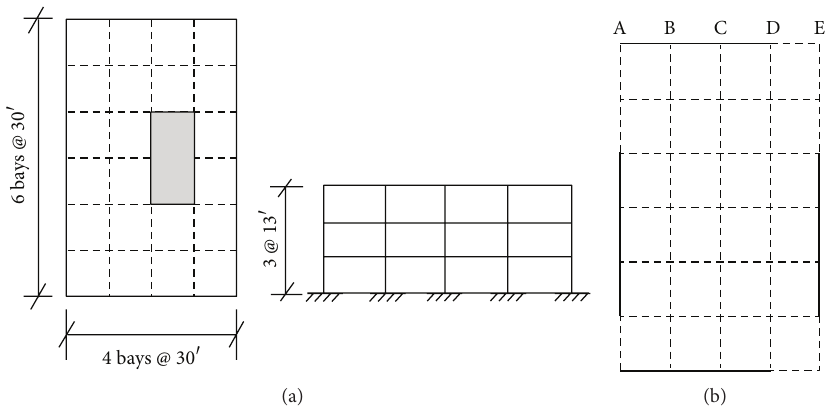
Figure 1: Configuration of the building. (a) Plan and elevation view and (b) perimeter moment frames.